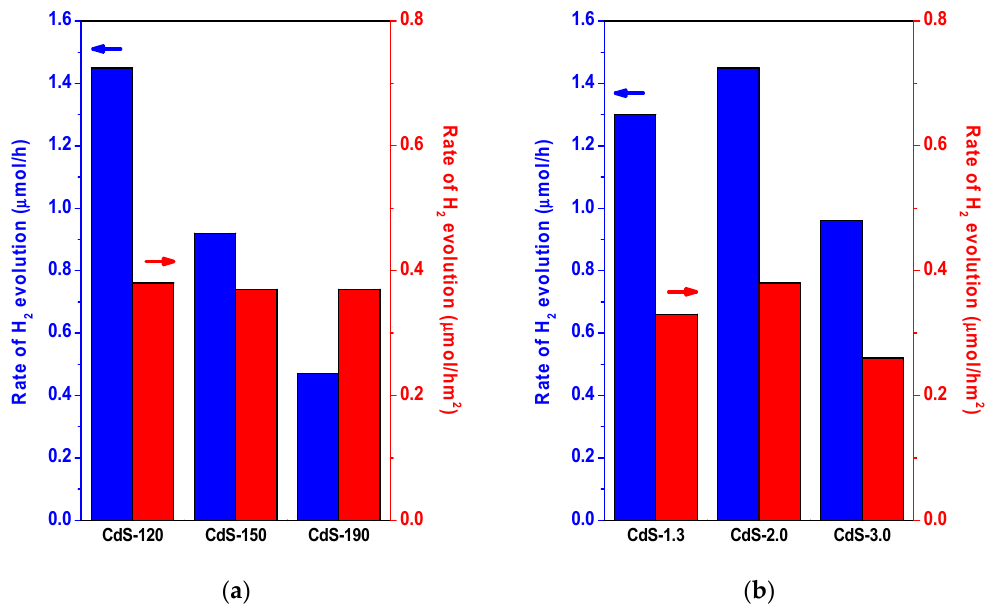
Figure 11. Surface-normalized hydrogen evolution rate (µmol/h m 2 ) over the CdS photocatalysts: ( a ) influence of solvothermal temperature (CdS-120, 150 and 190); ( b ) influence of H 2 O/thiourea ratio (CdS-1.3, 2.0 and 3.0).